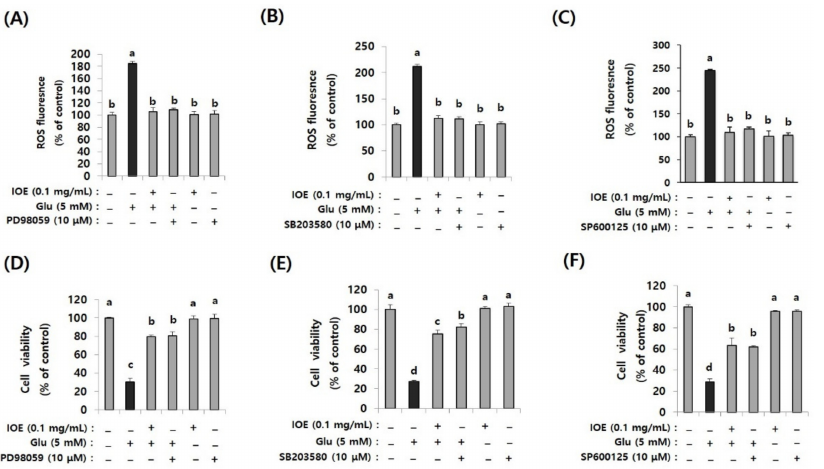
Figure 11. Glutamate-induced ROS overproduction and cytotoxicity in HT22 cells were restored by IOE as well as MAPK inhibitors. After pretreatment of HT22 cells with IOE (2 h) and MAPK inhibitors (1 h) (PD98059; MEK inhibitor, SB203580; p38 MAPK inhibitor, SP600125; JNK inhibitor) ROS overproduction was estimated by using a microplate fluorometer ( A – C ), and cell viability ( D – F ) was estimated by using a WST-1 Assay Kit. Non-treated cells (IOE, Glu, and inhibitors) were used for the control. Data shown are means ± SD. Glu: Glutamate. Experiments were conducted in triplicate and repeated three times with similar results. a: significant differences ( p < 0.05) when compared with b or c, or d; b: significant differences ( p < 0.05) when compared with a or c, or d; c: significant differences ( p < 0.05) when compared with a or b, or